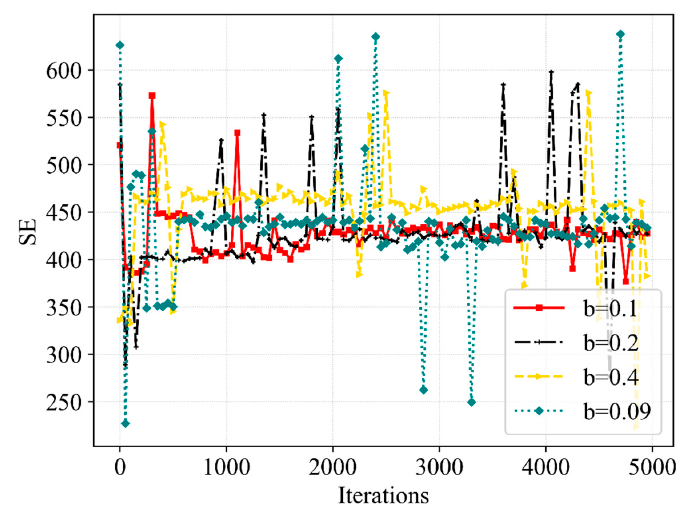
Figure 13. A comparative result of SE at various 𝑏